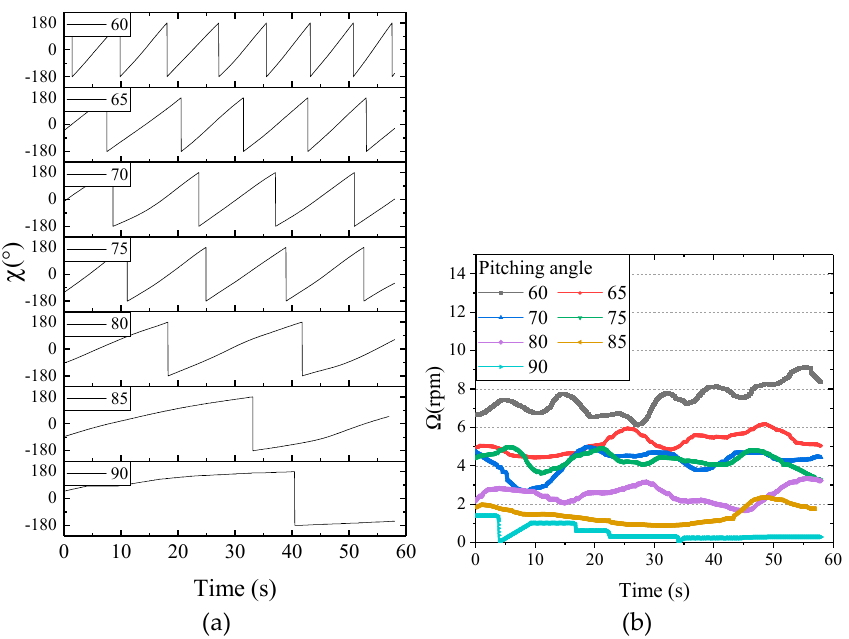
Figure 14. Time history of azimuth angle ( a ) and rotor speed ( b ) in the testing cases.